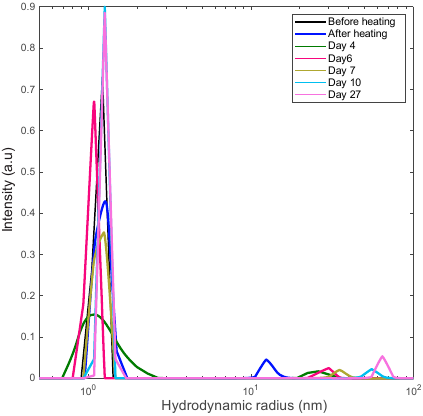
Figure 9. DLS distribution analysis of a 60 mg/mL lysozyme sample heated for 10 min at 80 ℃ to screen the effect of heating on the aggregation process.